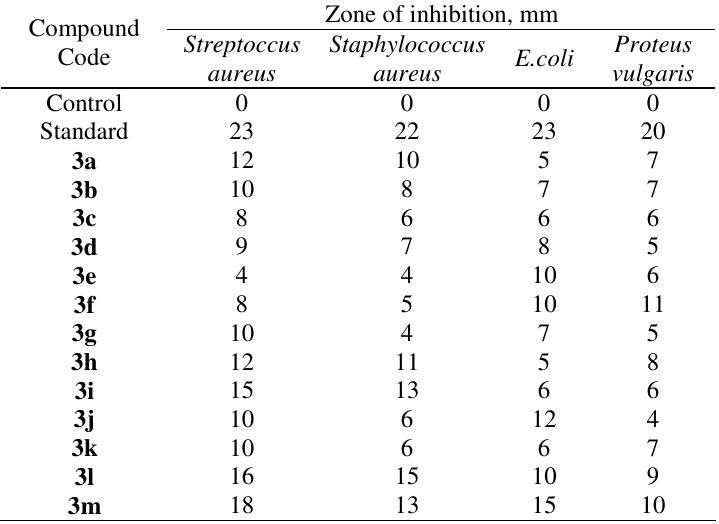
Table 1. Antibacterial activity of synthesized